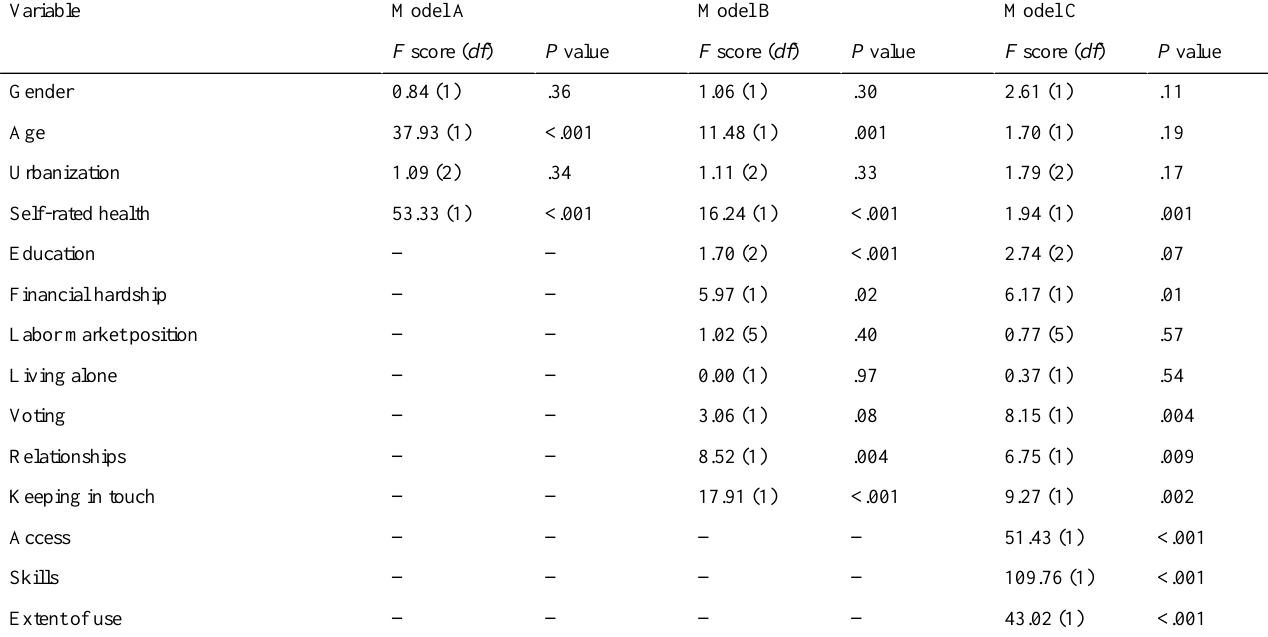
Table 2. Association of explanatory factors with perceived health benefits (analysis of covariance,